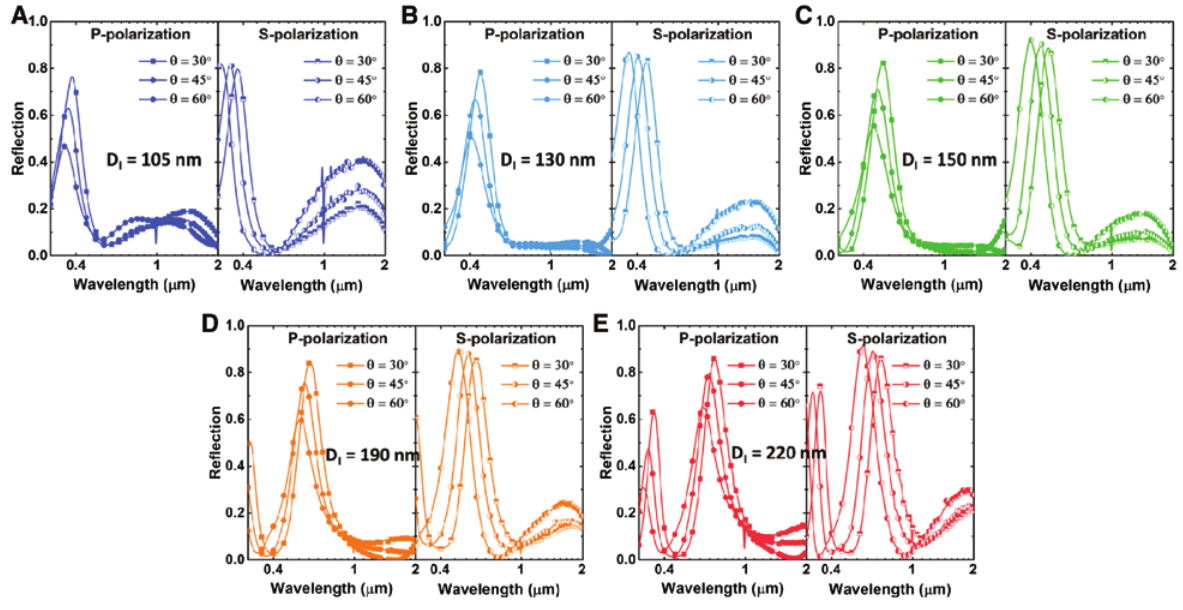
Figure 4: Angular absorption response of the MIMI cavities. The angular response of (A) blue, (B) cyan, (C) green, (D) orange, and (E) red colored filters under different incidence angles (i.e. 30 ° , 45 ° , and 60 ° ) and polarizations (s and p). In all samples, the reflection gets a blue shift as we go toward wider viewing